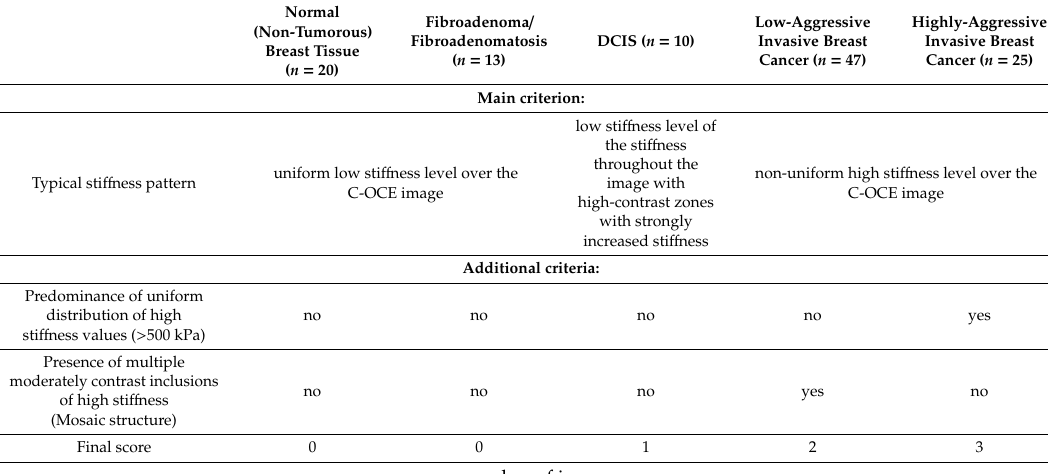
Table 3. Visual assessment criteria of compressional optical coherence elastography (C-OCE) images for distinguishing between non-tumorous and tumorous breast